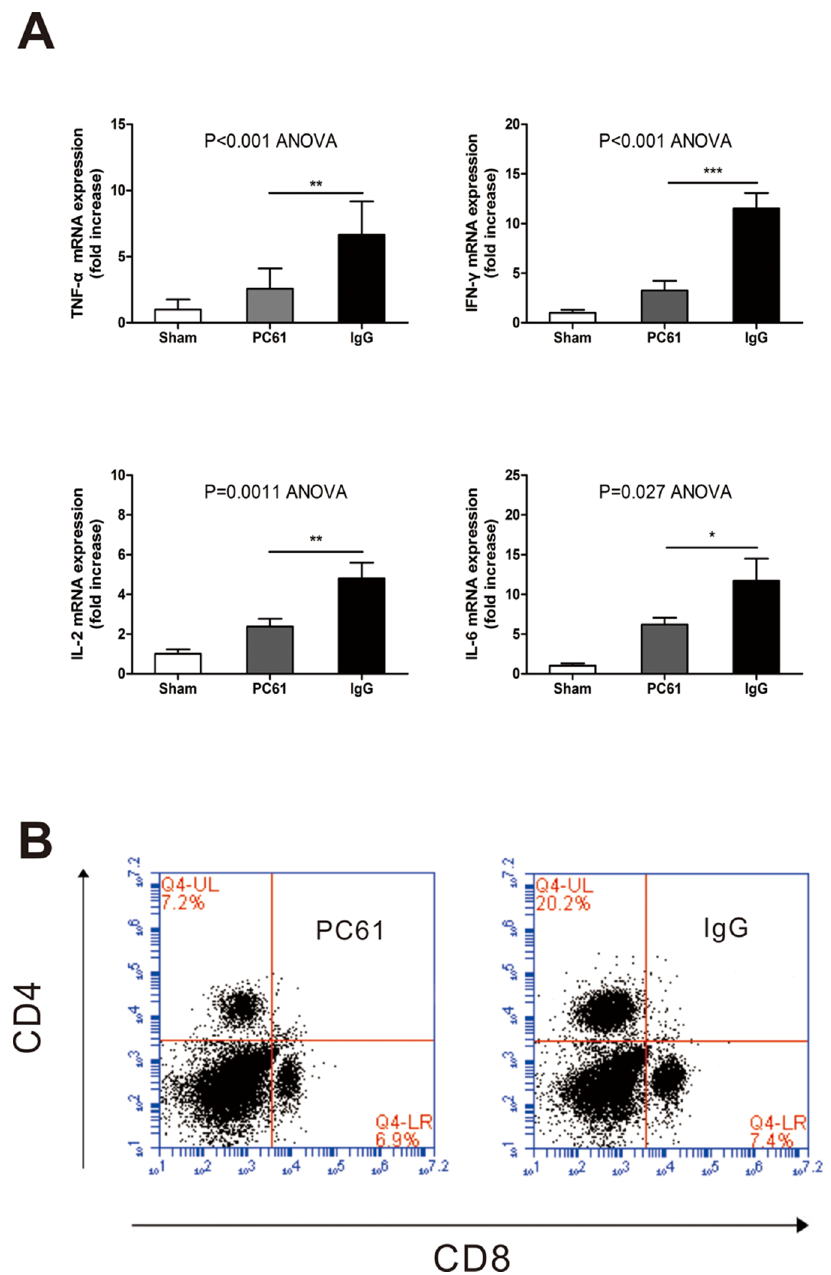
Figure 6. Anti-CD25 mAb pretreatment mitigated intrahepatic inflammatory milieu. (A) TNF- a , IFN- c , IL-2, and IL-6 mRNA expression among sham, PC61, and I/R group after hepatic ischemia and 60 min of reperfusion. Samples were analyzed by RT-PCR. Data are expressed as means 6 SE; n=6 per group. (B) Splenocytes were labeled with 5 mM 5-(and-6)-carboxyfluorescein diacetate, succinimidyl ester and co-cultured with samples’ protein in 5% CO 2 at 37 u C. After 72 hours proliferation was assessed by flow Cytometry. (*p , 0.05, **p , 0.01, ***P , 0.001).